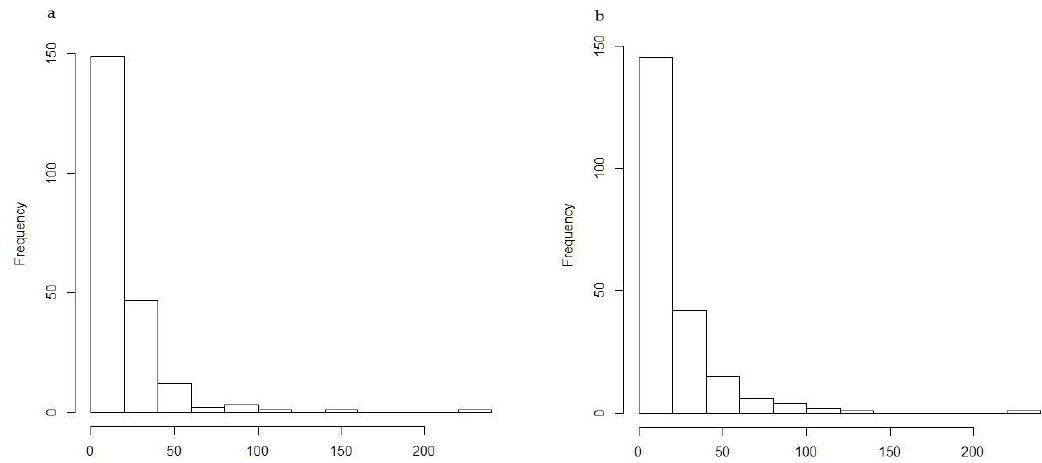
Figure 4. Frequency distribution of numbers of H. abietis adult males ( a ) and females ( b ) caught per trap across all attractant types.